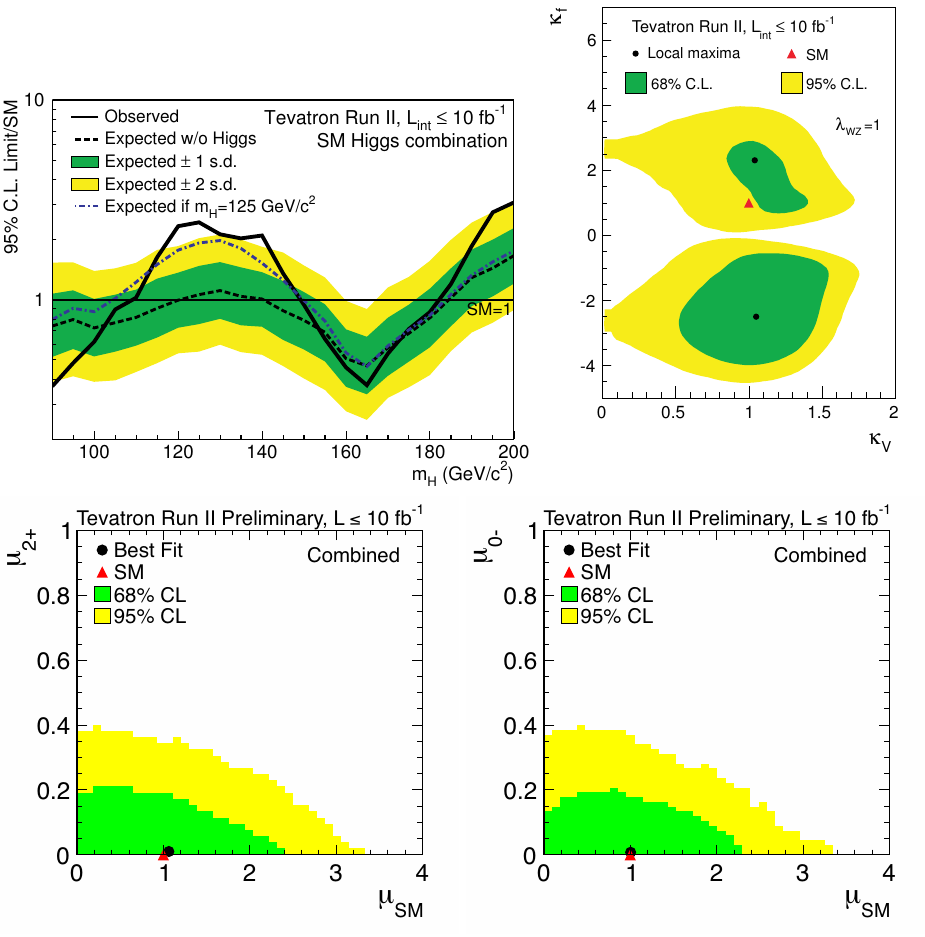
Figure 1. Top: Exclusion limits (left) and couplings of the SM Higgs boson at the Tevatron. Bottom: Tests of the spin and parity state of the Higgs boson at the